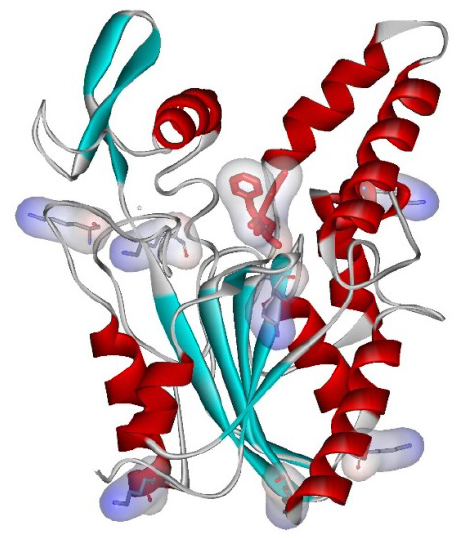
Figure 1. The catalytically active open conformation of Bc L (PDB code: 1YS1 [76]) with a substrate analogue (in red) and the surface exposed Lys residues (in CPK color).